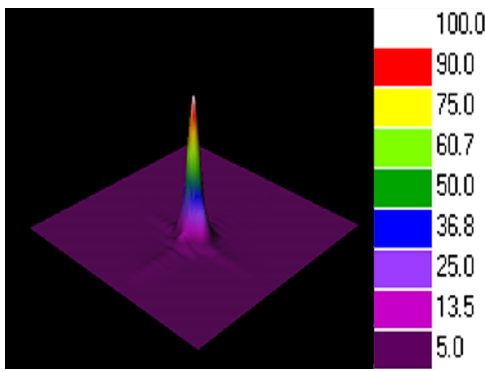
Figure 3. The light intensity distribution on the fiber end of the sensor by a near-field optical profiler.